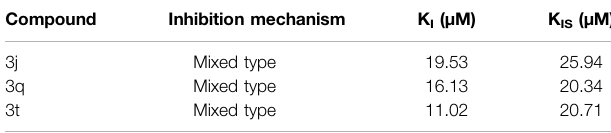
Table 2 . The higher K IS values compared to K I values indicated